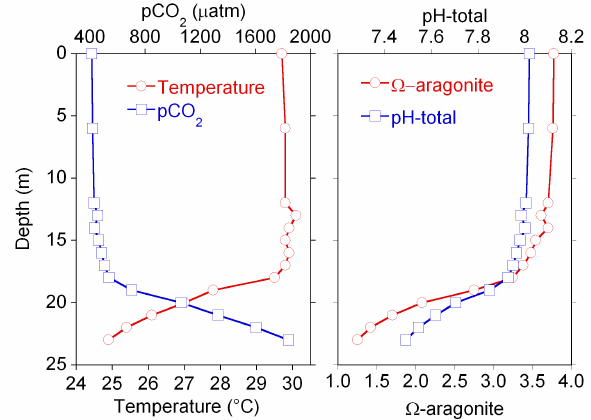
Fig. 4. Summertime vertical profiles from Devil’s Hole, Bermuda, showing temperature and p CO 2 (left panel), and aragonite satura- tion state ( (cid:127)) and pH-total (right panel). Due to the thermal stratifi- cation of the water column, CO 2 produced from microbial decom- position of organic material accumulates within the subthermocline layer producing low (cid:127) -aragonite and pH (see Andersson et al., 2007 for detailed discussion).